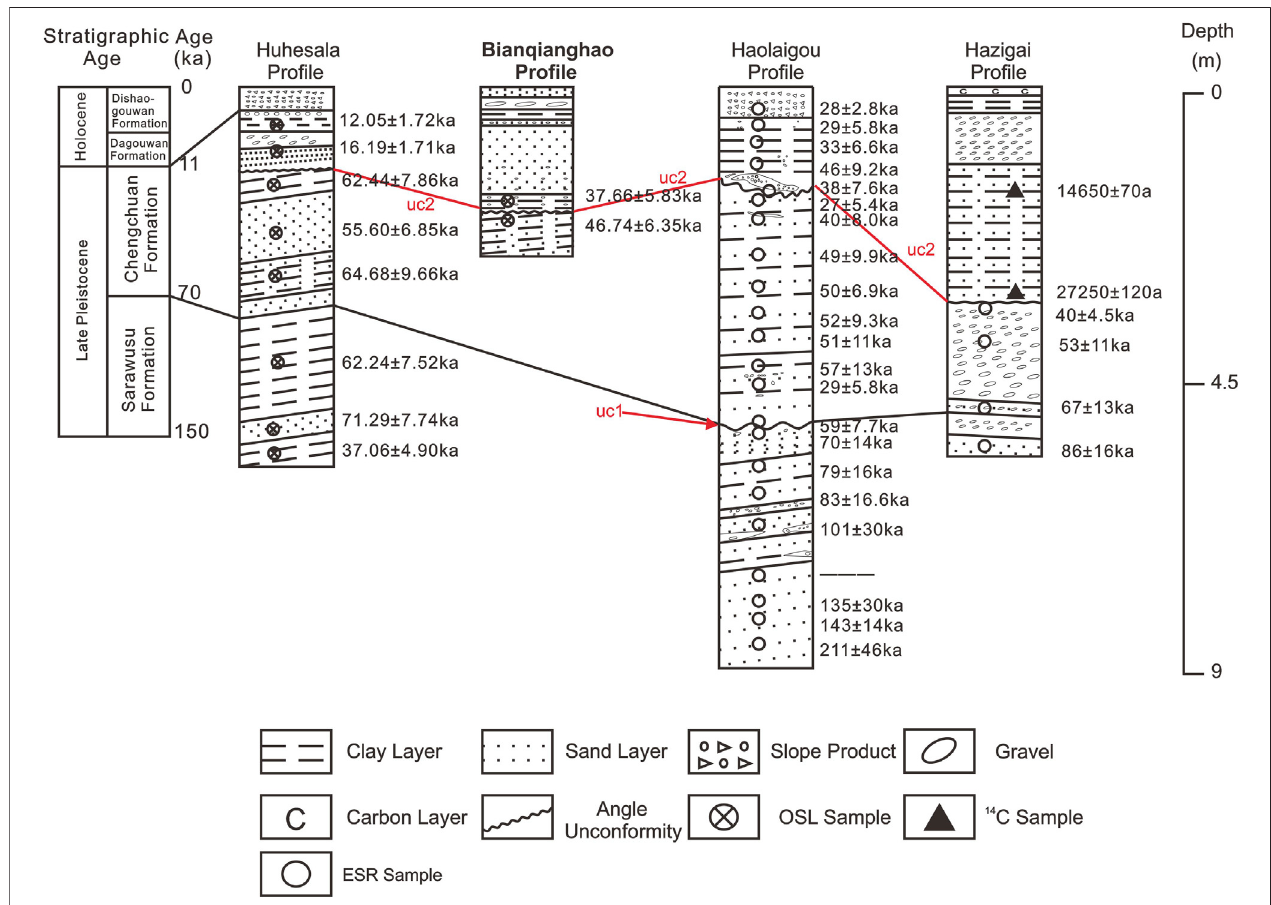
FIGURE4 | Geological logging and correlations of four sections. The Quaternary stratigraphic chronology ofthe Sarawusu River area was constructed bySu et al. (1997).